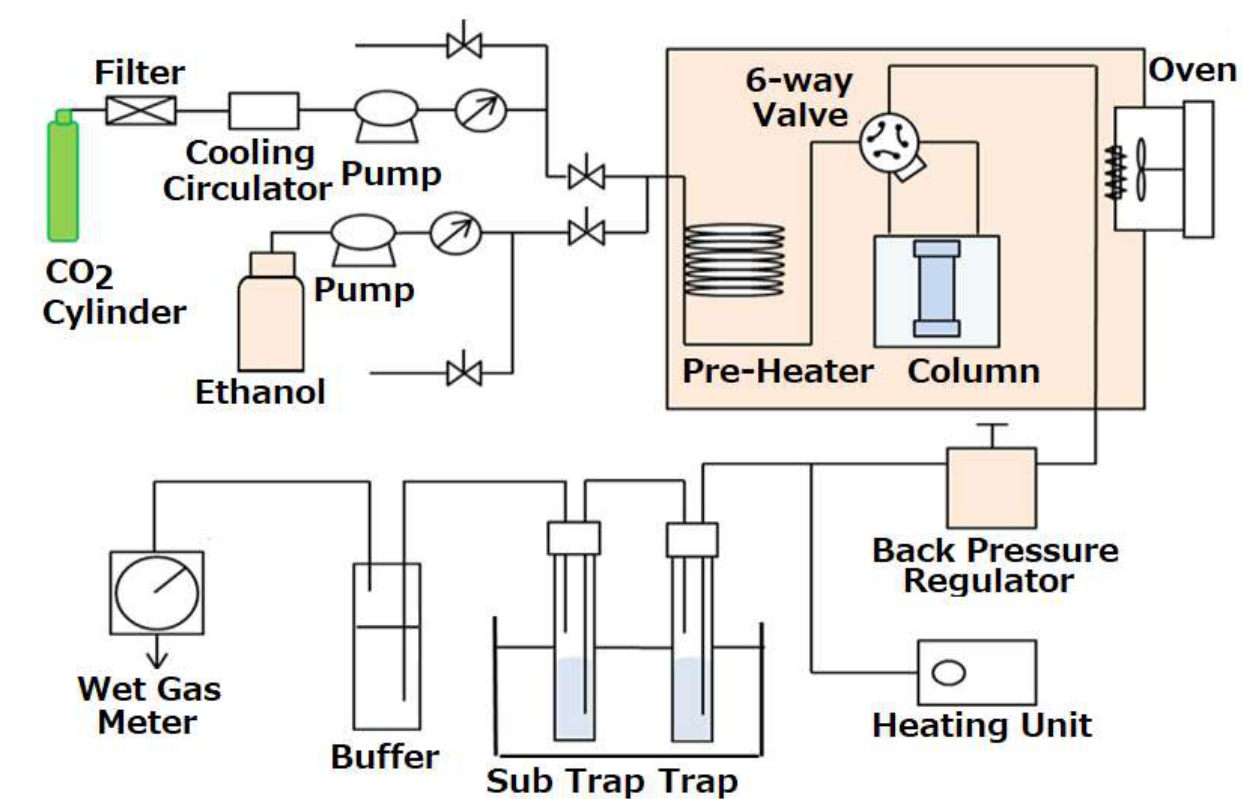
Figure 1. Experimental apparatus for solubility measurement.